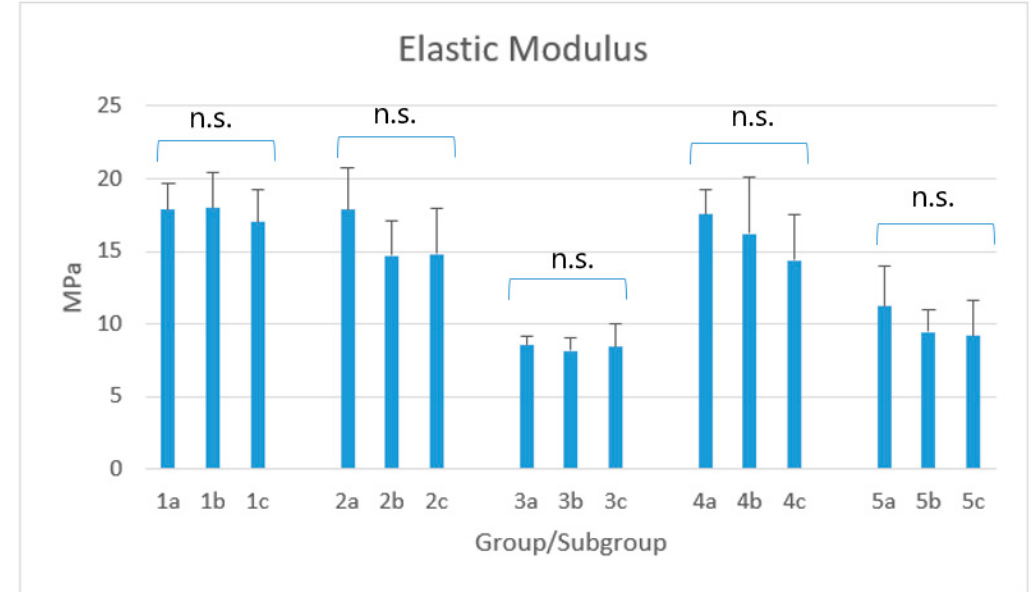
Figure 3. Mean elastic modulus (MPa) for each group/subgroup. Legend: 1: x-tra fil; 2: GrandioSO x-tra; 3: Admira Fusion x-tra; 4: VisCalor bulk; 5: Enamel Plus HRi. Subgroups A (1a–5a): 4-week storage in 50 mL distilled water (control subgroups); Subgroups B (1b–5b): 3-week storage in 50 mL distilled water + 1-week storage in 50 mL soft drink; Subgroups C (1c–5c): 4-week storage in 50 mL soft drink. n.s.; non-significant; The Kruskal–Wallis method showed significant differences among groups ( p < 0.0001). Post-hoc showed that the highest elastic modulus was reported for groups 1, 2, and 4, with no statistical difference neither among the corresponding subgroups ( p > 0.05) nor among the three subgroups of each material ( p > 0.05). Values reported for groups 3 and 5 were significantly lower ( p < 0.05) but, even this time, without significant differences neither among the corresponding subgroups, nor among the three subgroups of the two materials ( p > 0.05). Finally, the values of subgroups 4c and 5a showed no statistical difference among them ( p > 0.05).